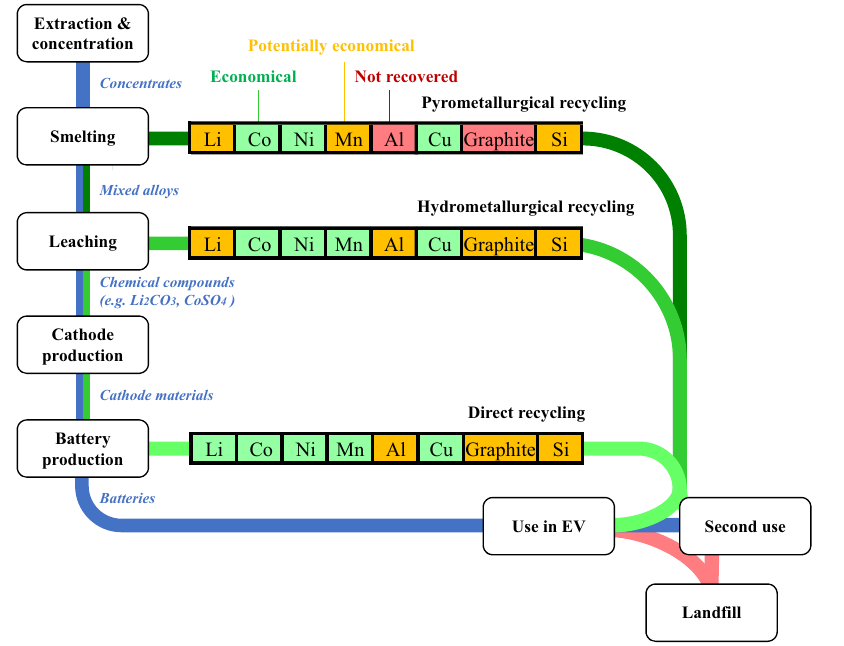
Fig. 5 Conceptual schematic showing how the three considered recycling scenarios close battery material loops and which materials are recovered. In reality not all materials go through all processing steps. For example, pyrometallurgical recycling (smelting) still requires hydrometallurgical processing (leaching) before cathode materials can be produced, while direct recycling is designed to recover cathode materials directly. In pyro- and hydrometallurgical recycling the recovery of Li may not be economical and in pyrometallurgical recycling graphite is incinerated and Al not recovered from the slag (see also